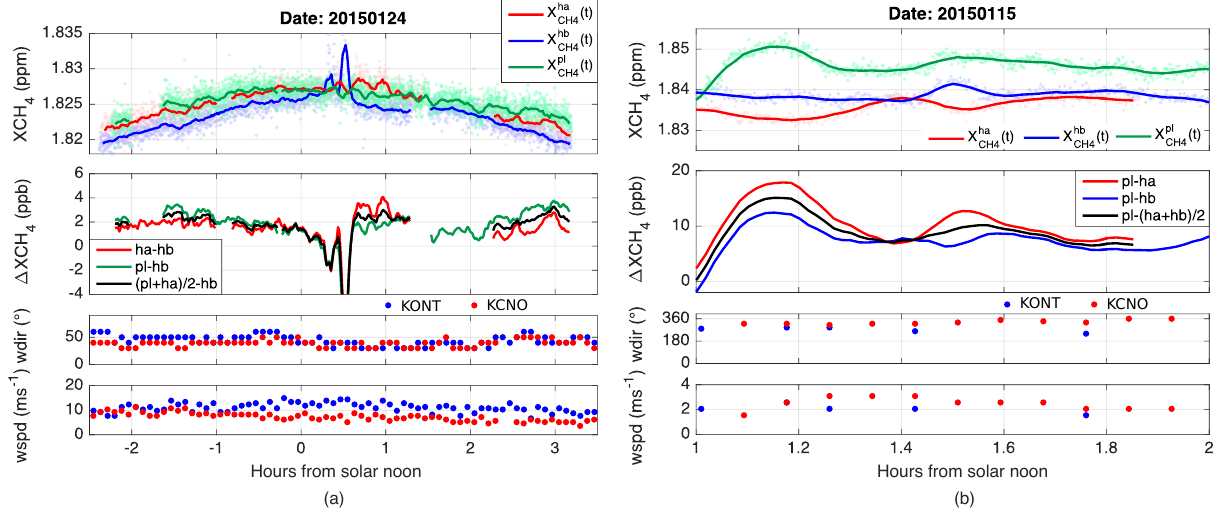
Figure 4. Column-averaged DMF measurements at three stations and downwind-minus-upwind column differences (solar zenith angle ≤ 70 ◦ ). On 24 January, (cid:49)X ∼ 2 ppb most of the day, 10 times larger than our measurement precision (a) . On 15 January, CH 4 was steady at (cid:49)X CH (t) was ∼ 10ppb, about 5 times larger than on 24 January, showing inverse proportionality to the wind speed (b) 4